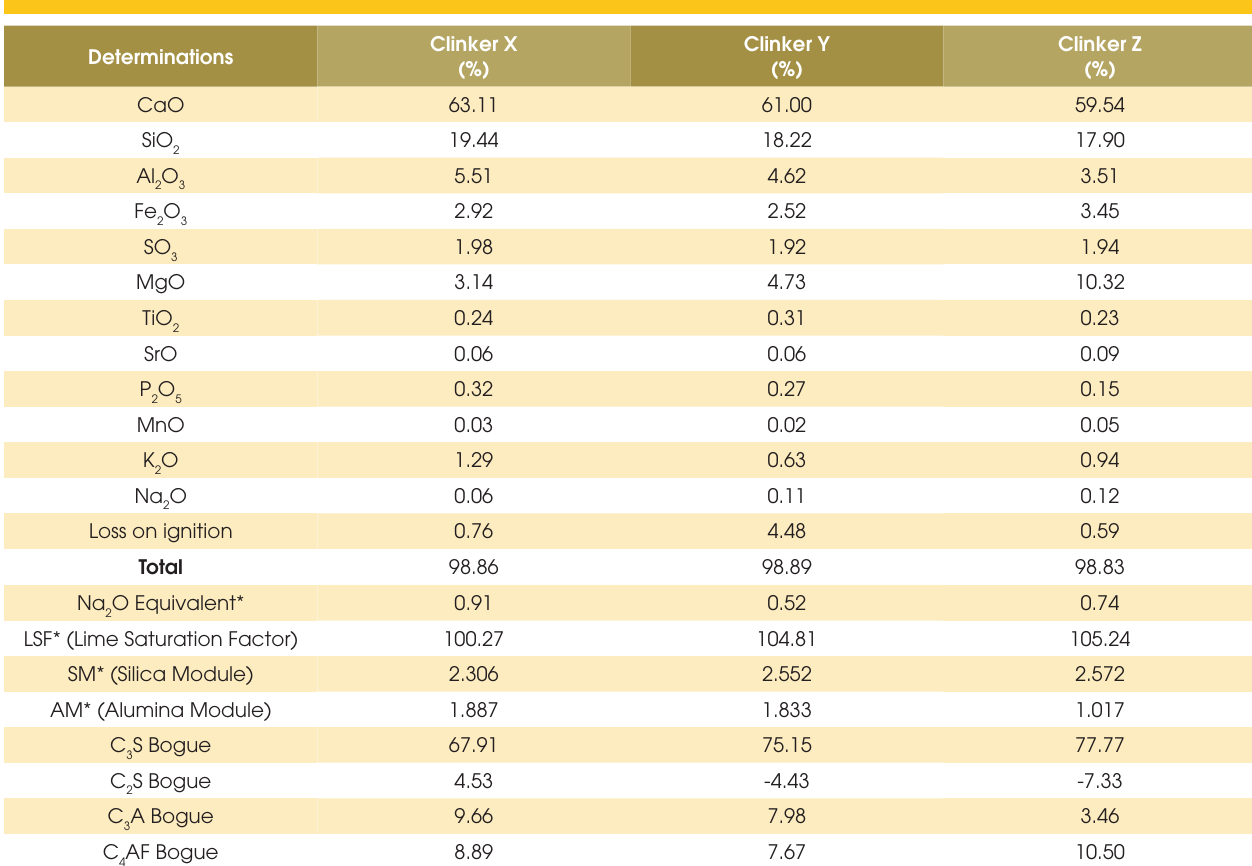
Table 7 – Chemical and mineralogical composition of the clinkers X, Y and Z